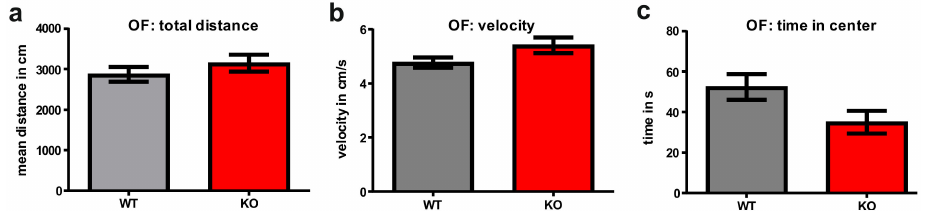
Figure 1. Behavior of FTSJ1-deficient mice (KO) and age-matched littermates (WT) in the open field (OF) test: mice of both genotypes explored the OF arena. ( a ) Within a given time, the mouse types of did not differ concerning the distance they moved. ( b ) FTSJ1-deficient mice showed comparable velocity when moving through the open field arena. ( c ) The FTSJ1-deficient mice spent less time in the center of the OF as compared to their controls. Despite this obvious effect, the difference was not statistically significant ( p = 0.061). Data are expressed as mean ±